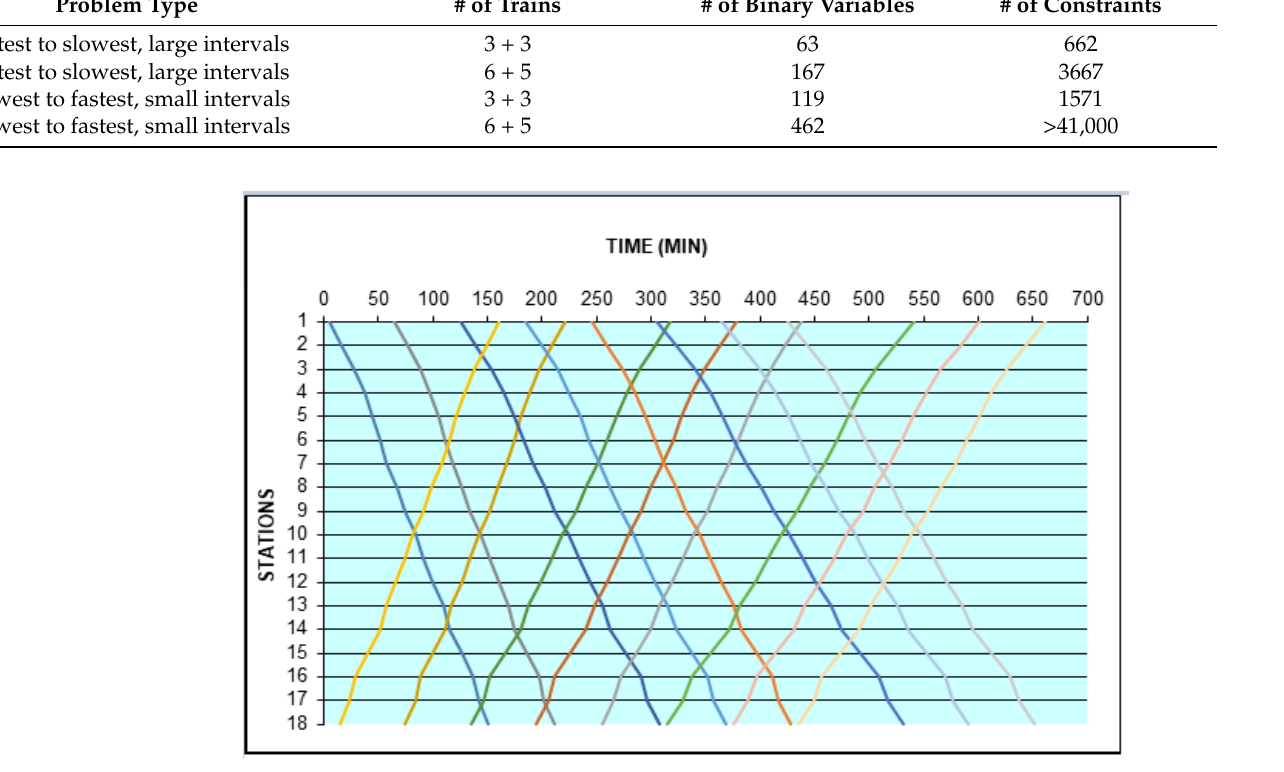
Figure 4. The solved (optimal) state of the special 8 + 8 train instance. Encouraged by the success in solving the 8 + 8 train special instance, we also tried a 13 + 13 problem formed with the same logic. Even the 13 + 13 train problem was solved in 80 s. This implies that a 13 + 13 instance can be easier than a 6 + 5 instance if it is specially formed. These findings suggest that the number of trains and stations cannot accurately define the difficulty of the problem instance. The frequency and entrance time order of the trains are also required to define the difficulty.